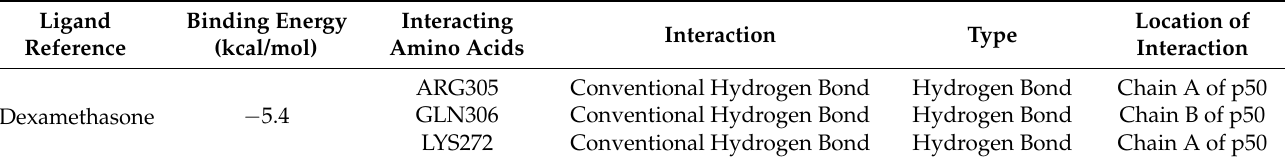
Table 5. Binding energy of reference compound dexamethasone with the p50 subunit in the NF- κ B